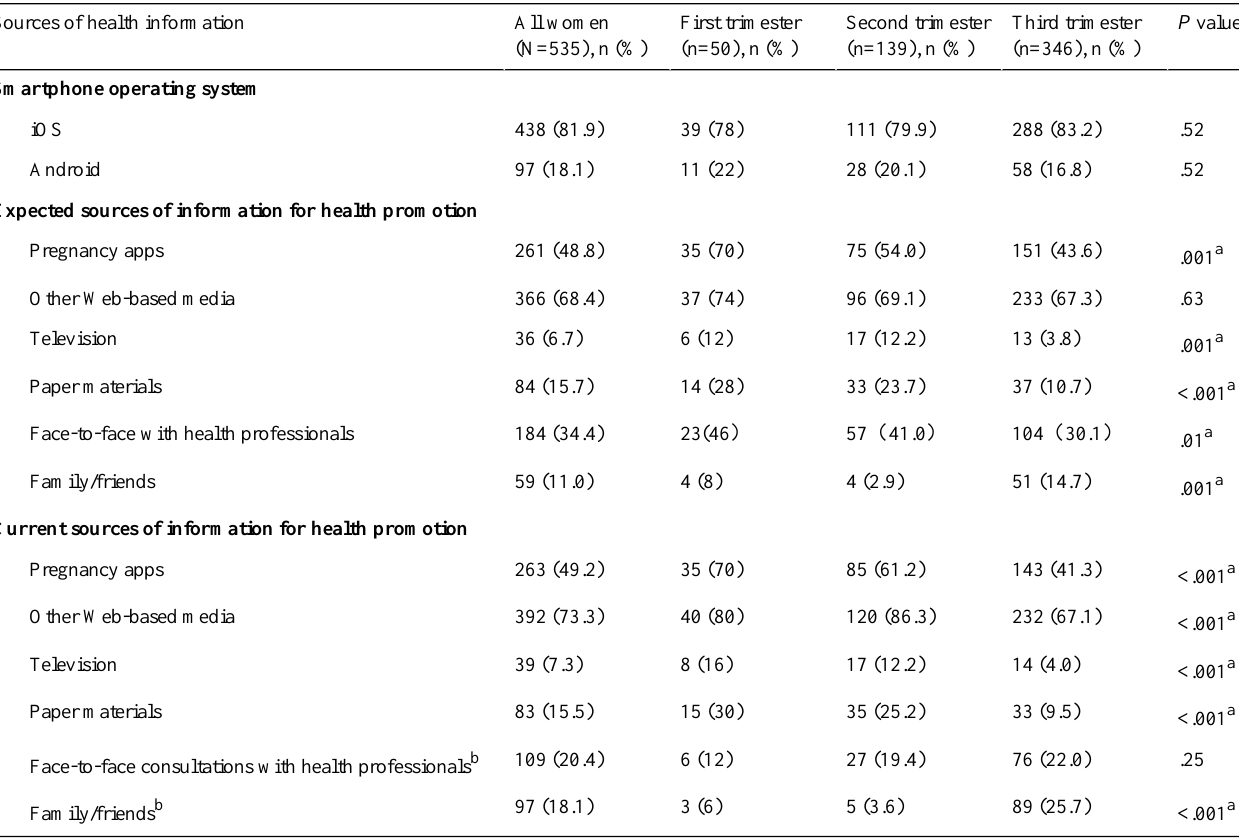
Table 2. Sources of health information by trimester of pregnancy of Chinese women in Shanghai, China, 2018.